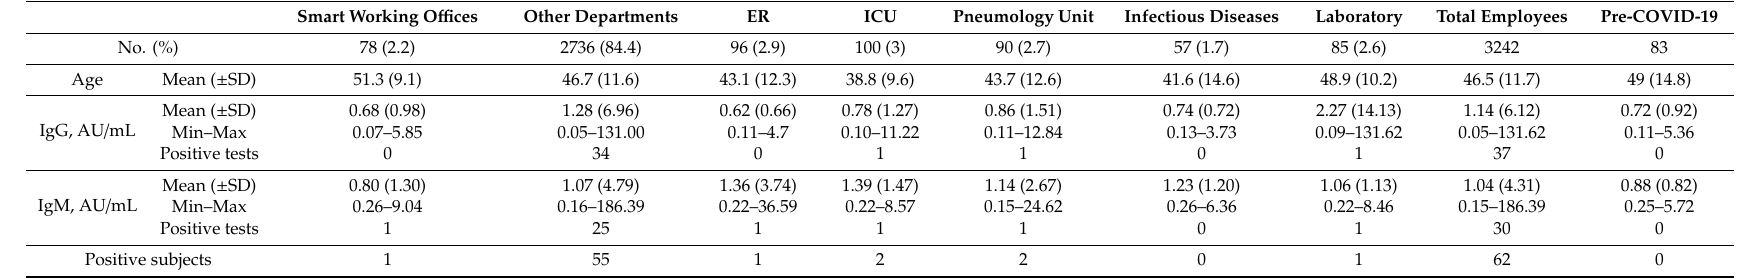
Table 1. Demographics and serological data of enrolled Policlinico Riuniti healthcare workers and the control